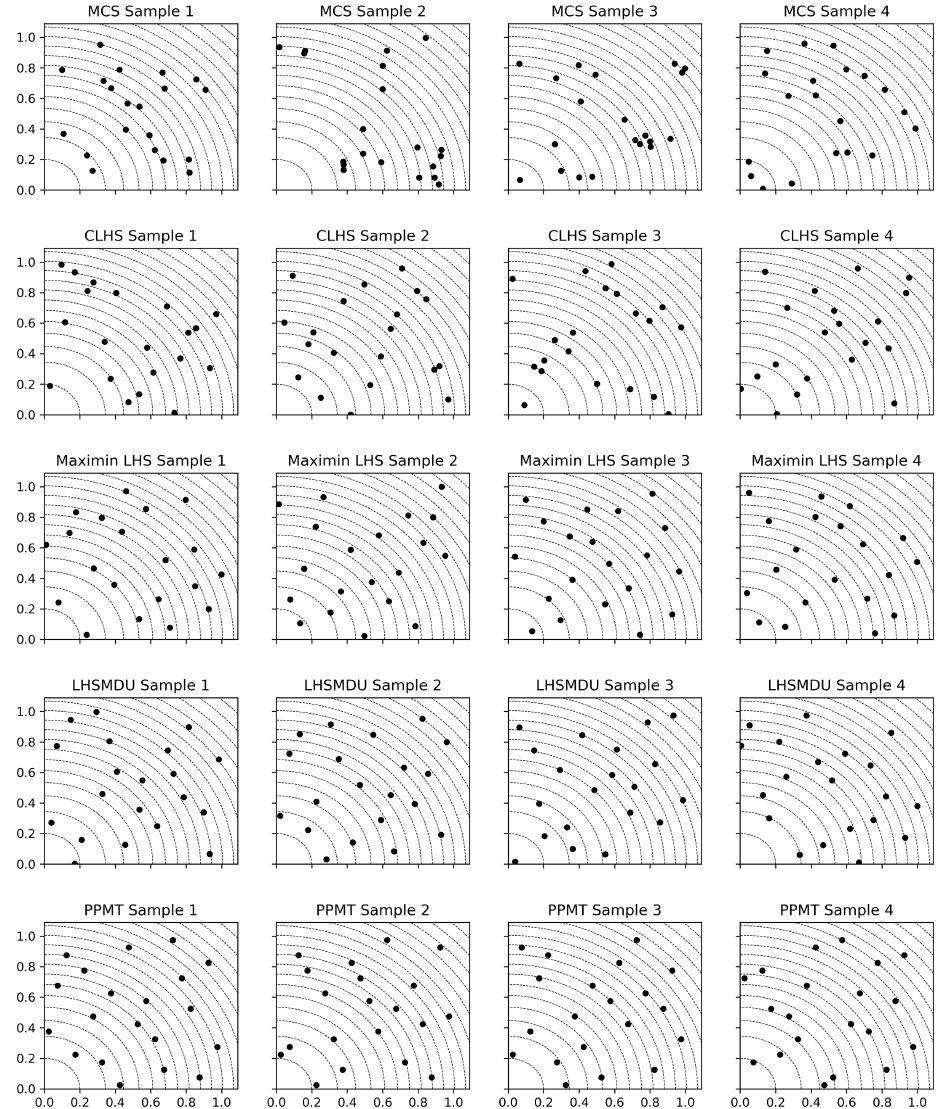
Figure 6. Four sets of samples with n = 20 realizations generated by each sampling technique in a two-dimensional sampling space where the random variables are